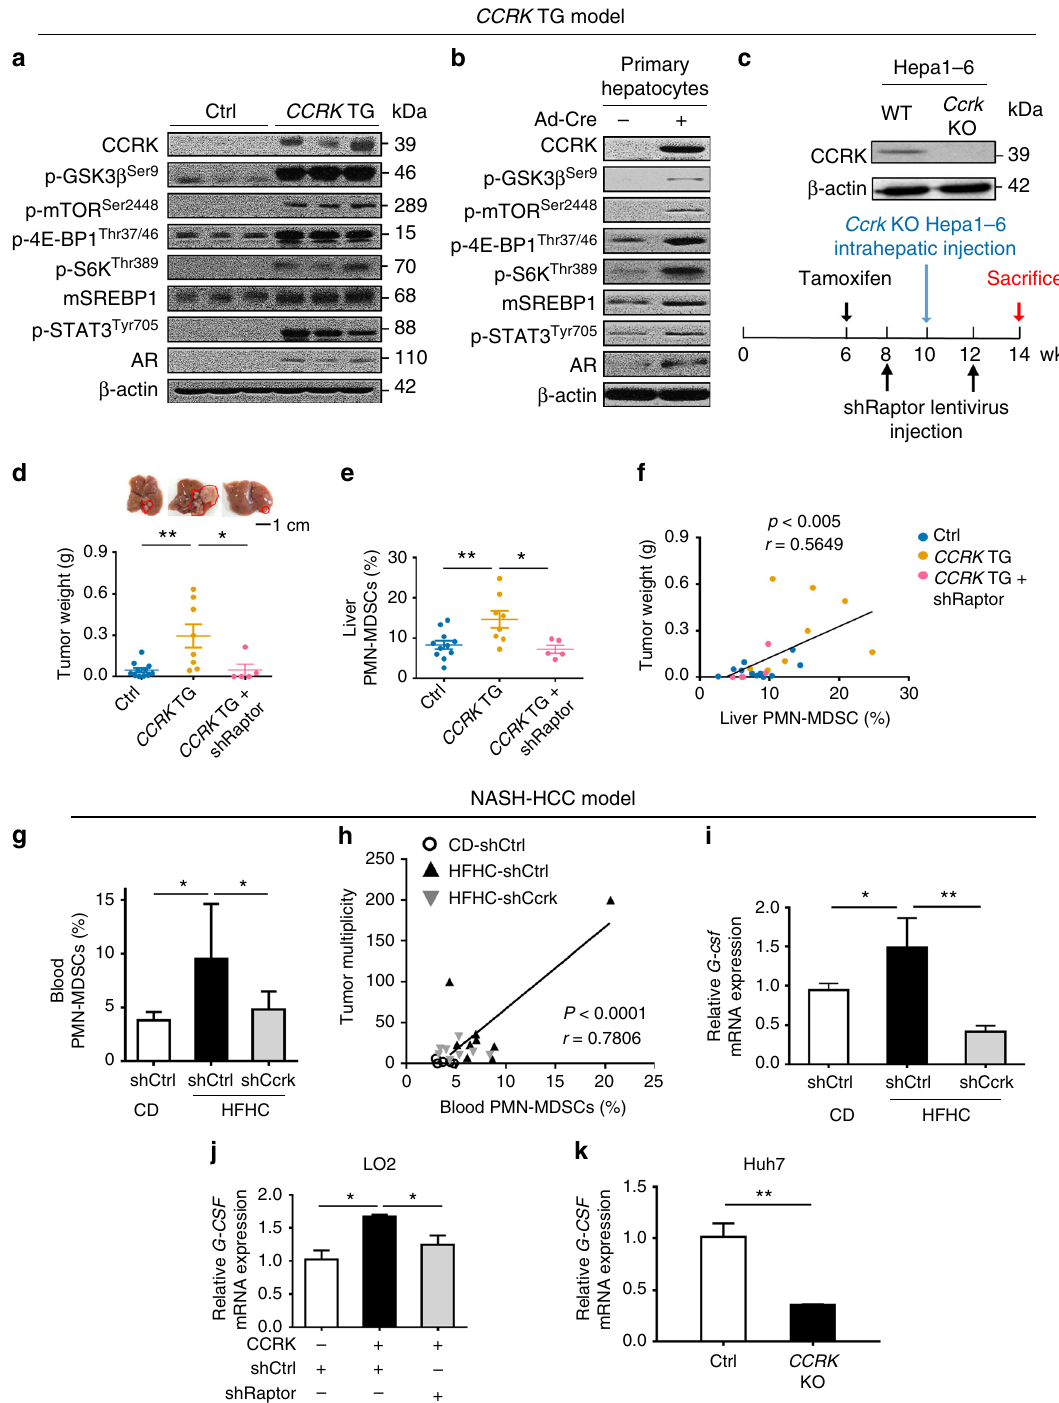
Fig. 6 Hepatic CCRK-mTORC1 signaling recruits MDSCs to form a tumor-prone liver microenvironment. a mTORC1 signaling was activated in the livers of CCRK TG mice. The downstream molecules of mTORC1 signaling were detected by Western blot. b mTORC1 signaling components were activated in the primary hepatocytes isolated from CCRK TG mice. c Schematic diagram of CCRK TG mouse model with intrahepatic injection of Ccrk KO Hepa1 – 6 cells by CRISPR/Cas9, and lentiviral-mediated Raptor knockdown. d CCRK TG mice ( n = 8) developed signi fi cantly larger tumors compared to controls ( n = 11), which was abolished by down-regulation of Raptor (shRaptor; n = 5) (scale bar = 1 cm). e PMN-MDSCs were induced in CCRK TG mice, but were reduced after Raptor knockdown, and f PMN-MDSC levels positively correlated with tumor weight. g PMN-MDSCs were induced by HFHC diet, but were reduced by Ccrk knockdown in NASH-HCC model (CD + shCtrl, n = 8; HFHC + shCtrl, n = 15; HFHC + shCcrk, n = 15), wherein h PMN-MDSC levels positively correlated with tumor multiplicity. i G-csf mRNA levels were induced by HFHC diet, but were reduced by Ccrk knockdown in NASH-HCC model. j G-CSF mRNA level was augmented by CCRK over-expression in LO2 cells, which could be attenuated by Raptor knockdown. k G-CSF mRNA expression was down- regulated in CCRK KO Huh7 cells. Data are presented as mean ± SD. * p < 0.05 and ** p < 0.01 as calculated by one-way ANOVA followed by Bonferroni post hoc test ( d , e , g , i , j ), Pearson correlation ( f , h ), and unpaired two-tailed Student ’ s t -test ( k